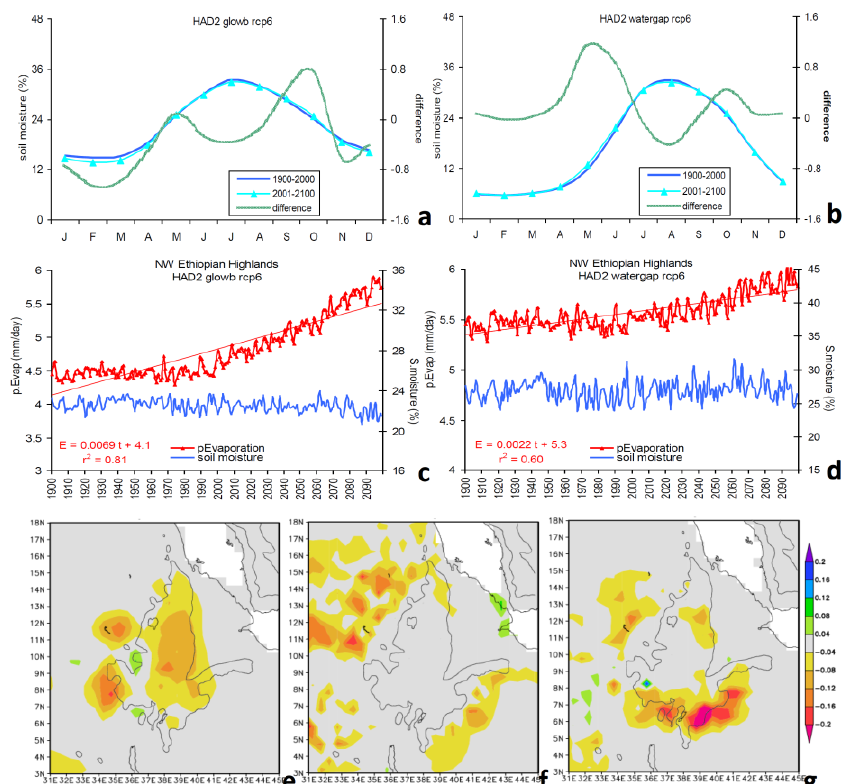
Figure 6. Hadley2-rcp6 annual cycle of S in past, future, and difference: ( a ) glowb and ( b ) watergap. Hadley2-rcp6 projected time series of annual S and E from ( c ) glowb and ( d ) watergap, and E slope (mm day − 1 /yr) and r 2 fit; scales vary slightly. S trend maps for Jul – Oct wet season: ( e ) ECMWF past (1900 – 2018), ( f ) glowb future (2001 – 2100), and ( g ) watergap future (% yr − 1 ). 1500 m elevation contour delineates the highlands.